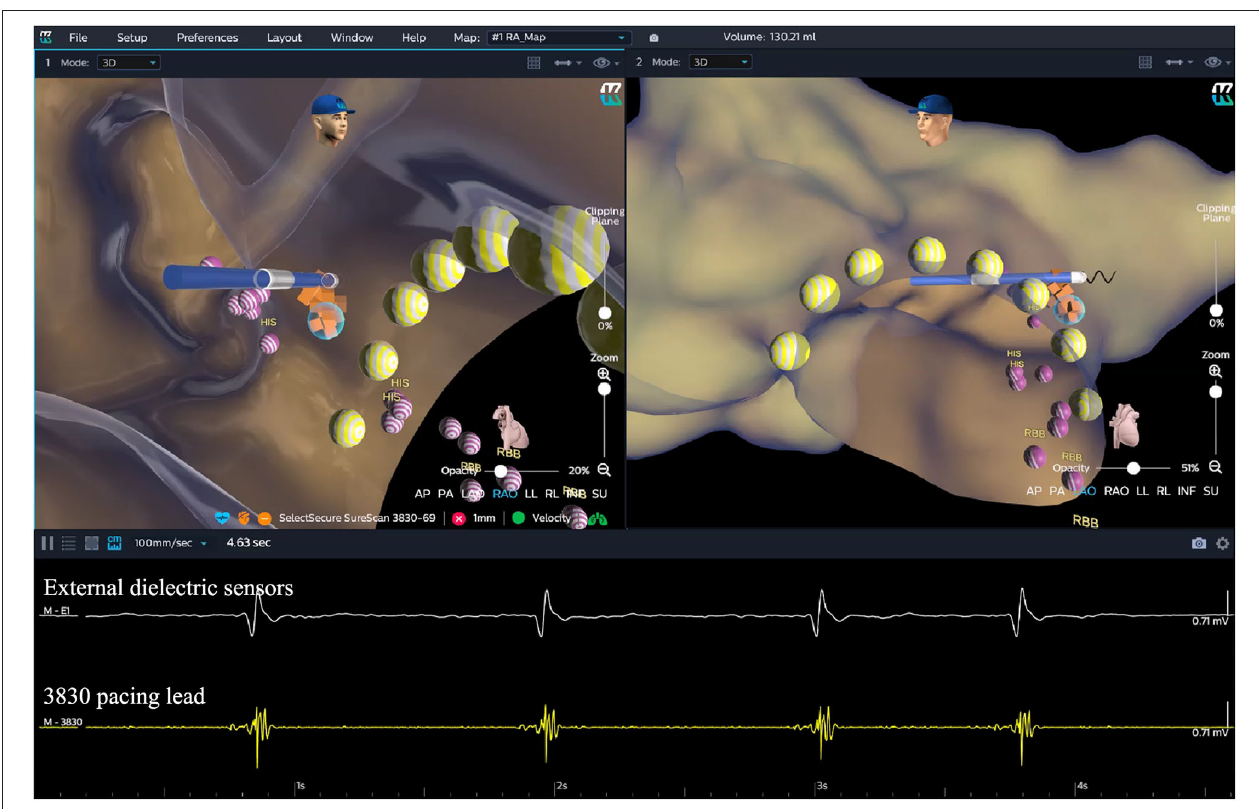
FIGURE 5 | HB lead deployment in the EAM-guided group. After the HB region was successfully marked, the lead was navigated to the HB region under the guidance of the KODEX-EPD system without fluoroscopy. The glass view provided by this system (setting of “opacity”) could give an enhanced perception of the lead location and orientation within the heart. The lead was finally fixed in the target HB region. The yellow dots represent the path of the tricuspid valve annulus. The purple dots represent the sites where the HB potential can be recorded. The orange dots represent the target HB region. EGMs from top to bottom showed the cardiac signal recorded from the external dielectric sensors and the 3830 pacing lead, respectively. EAM, electroanatomical mapping; EGM, electrogram; HB, His bundle; RBB, right bundle